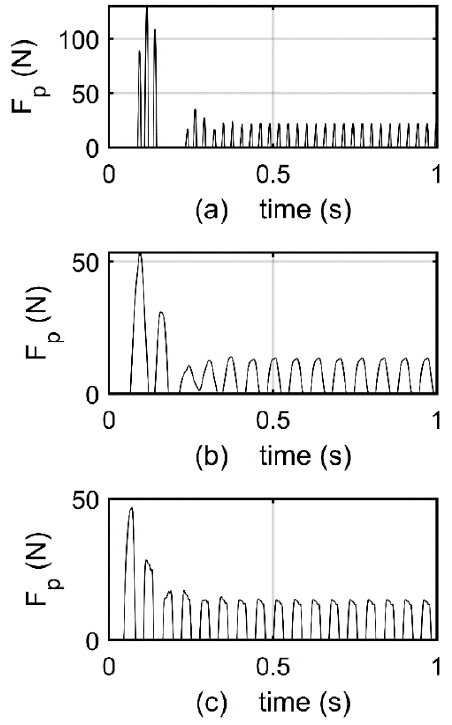
Figure 3. Closed-loop system response for delay dependent system with trivial initial